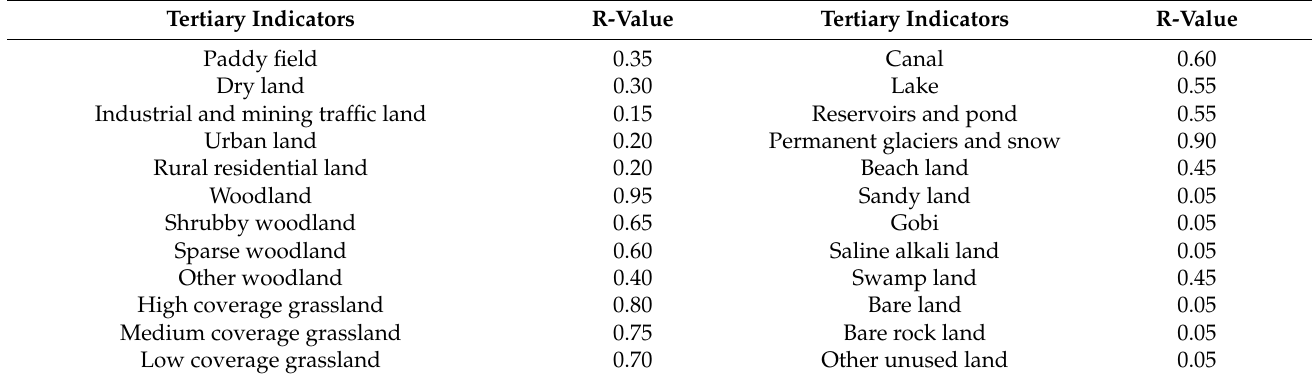
Table 2. R-value of tertiary